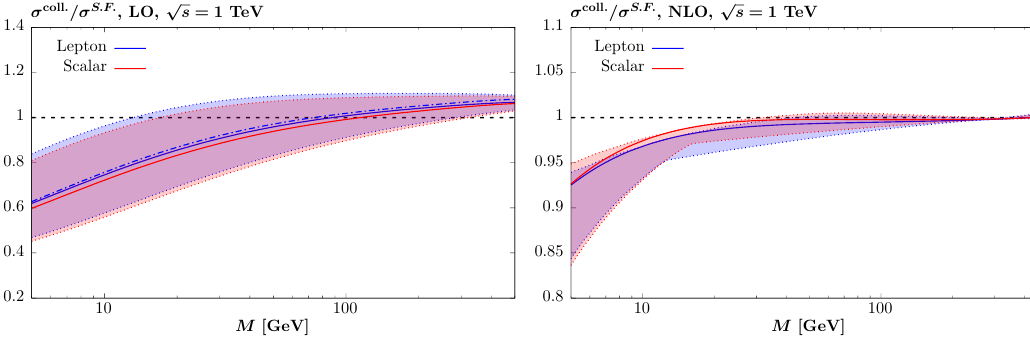
Figure 1 . Ratio of the cross sections for heavy lepton and scalar (with mass M ) production calculated within the approximate collinear approach (3.13), to the structure function result (3.4). The left (right) (cid:12)gures correspond to the LO O ( (cid:11) ) (NLO O ( (cid:11) 2 )) cases, while in the LO case the result of the equivalent photon approximation is also shown for lepton production (dot-dashed line). The band correspond to variations in the factorization/renormalization scales by a factor of two around the central value (cid:22) = M , indicated by the solid